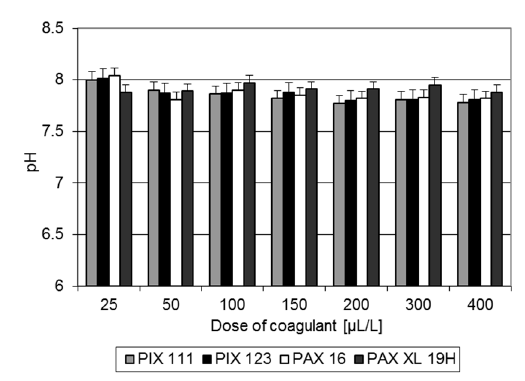
Figure 3. pH during coagulation in the doses of coagulants from 25 to 400 μ